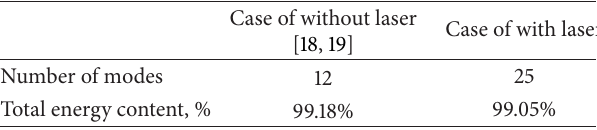
Table 2: Number of modes and energy